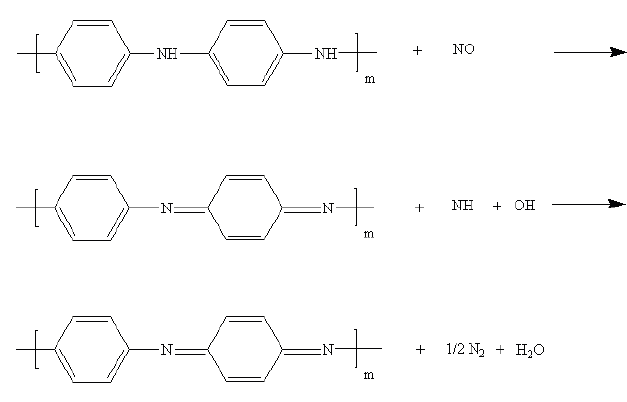
Figure 9. The proposed sensing mechanism.